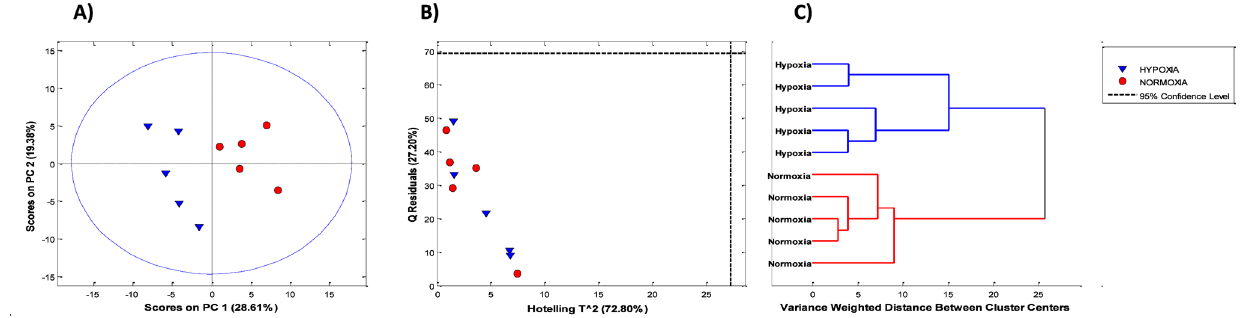
Figure 1. Principal component analysis of the metabolomic profiles of retina tissues. A) Score plot of PC1 vs. PC2; B) residual Q versus the Hotelling’s T 2 statistics; C) dendrogram obained by hierarchical cluster